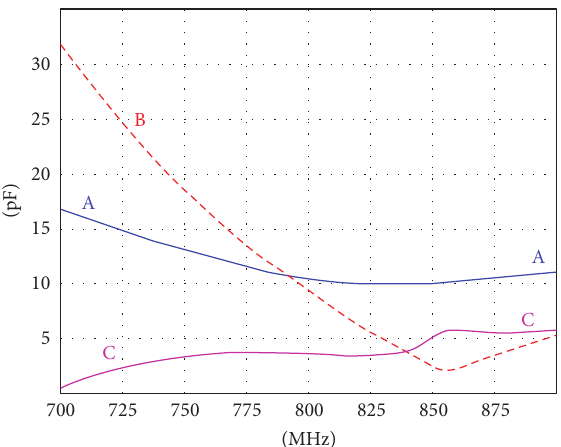
realize C 𝑈 in the lossless MAPMUP antenna tuner: 𝐶 𝑈𝐺 is curve A; 𝐶 𝐶 𝑈𝑁 is curve B; and 𝑈𝐹 is curve